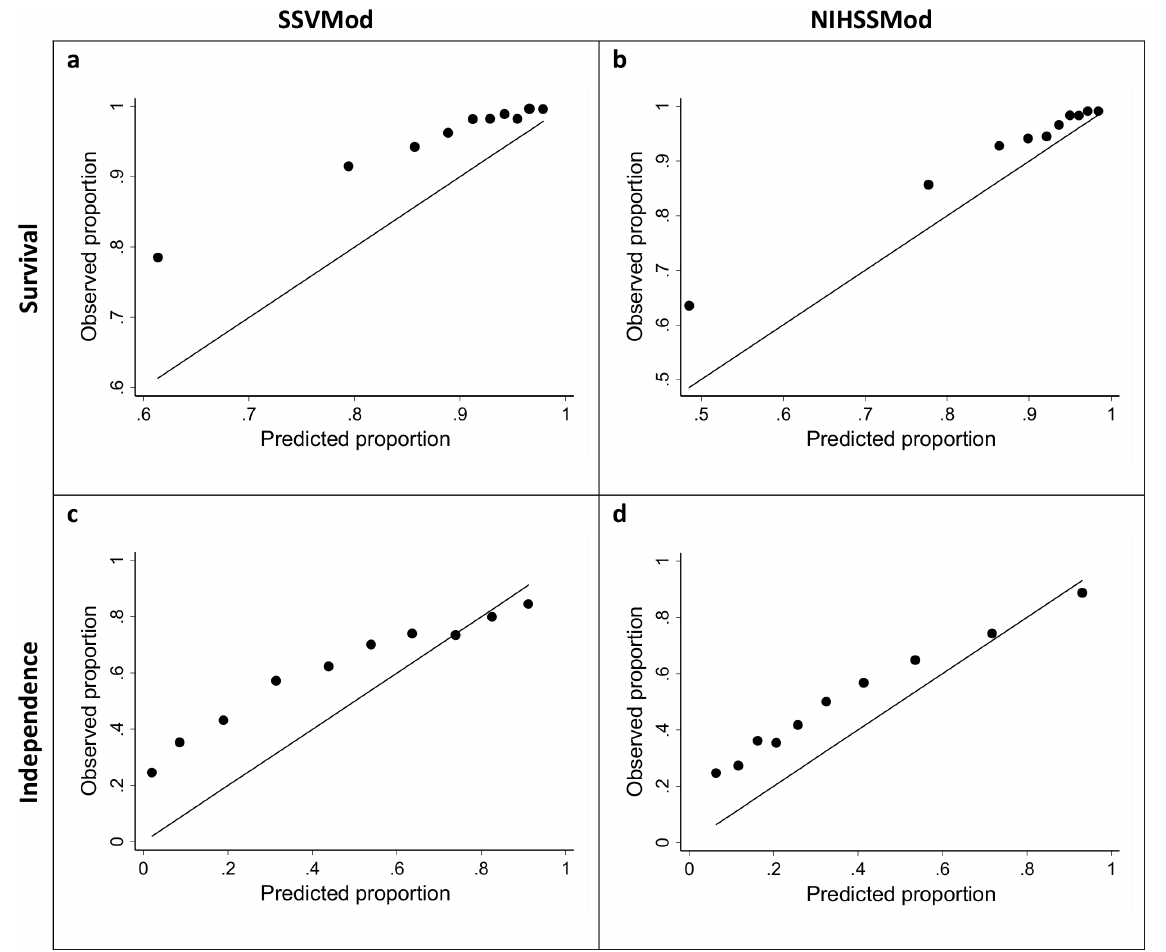
Fig 2. Calibration plots for survival and independence, for the total sample and based on deciles of patient numbers. Survival: assessed at 30 days for the SSVMod and at 100 days for the NIHSSMod. Independence: assessed at 6 months for the SSVMod and at 3 months for the NIHSSMod. For illustrative clarity, the origins for the axes vary between plots.